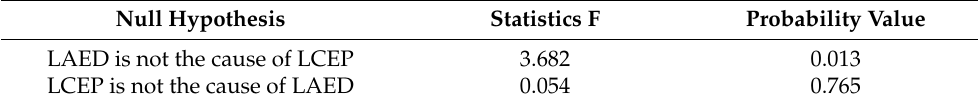
Table 4. The Granger test of the logarithmic treatments of AED and CEP (LAEG and LCEP, respectively). Null Hypothesis Statistics F Probability Value LAED is not the cause of LCEP 3.682 0.013 LCEP is not the cause of LAED